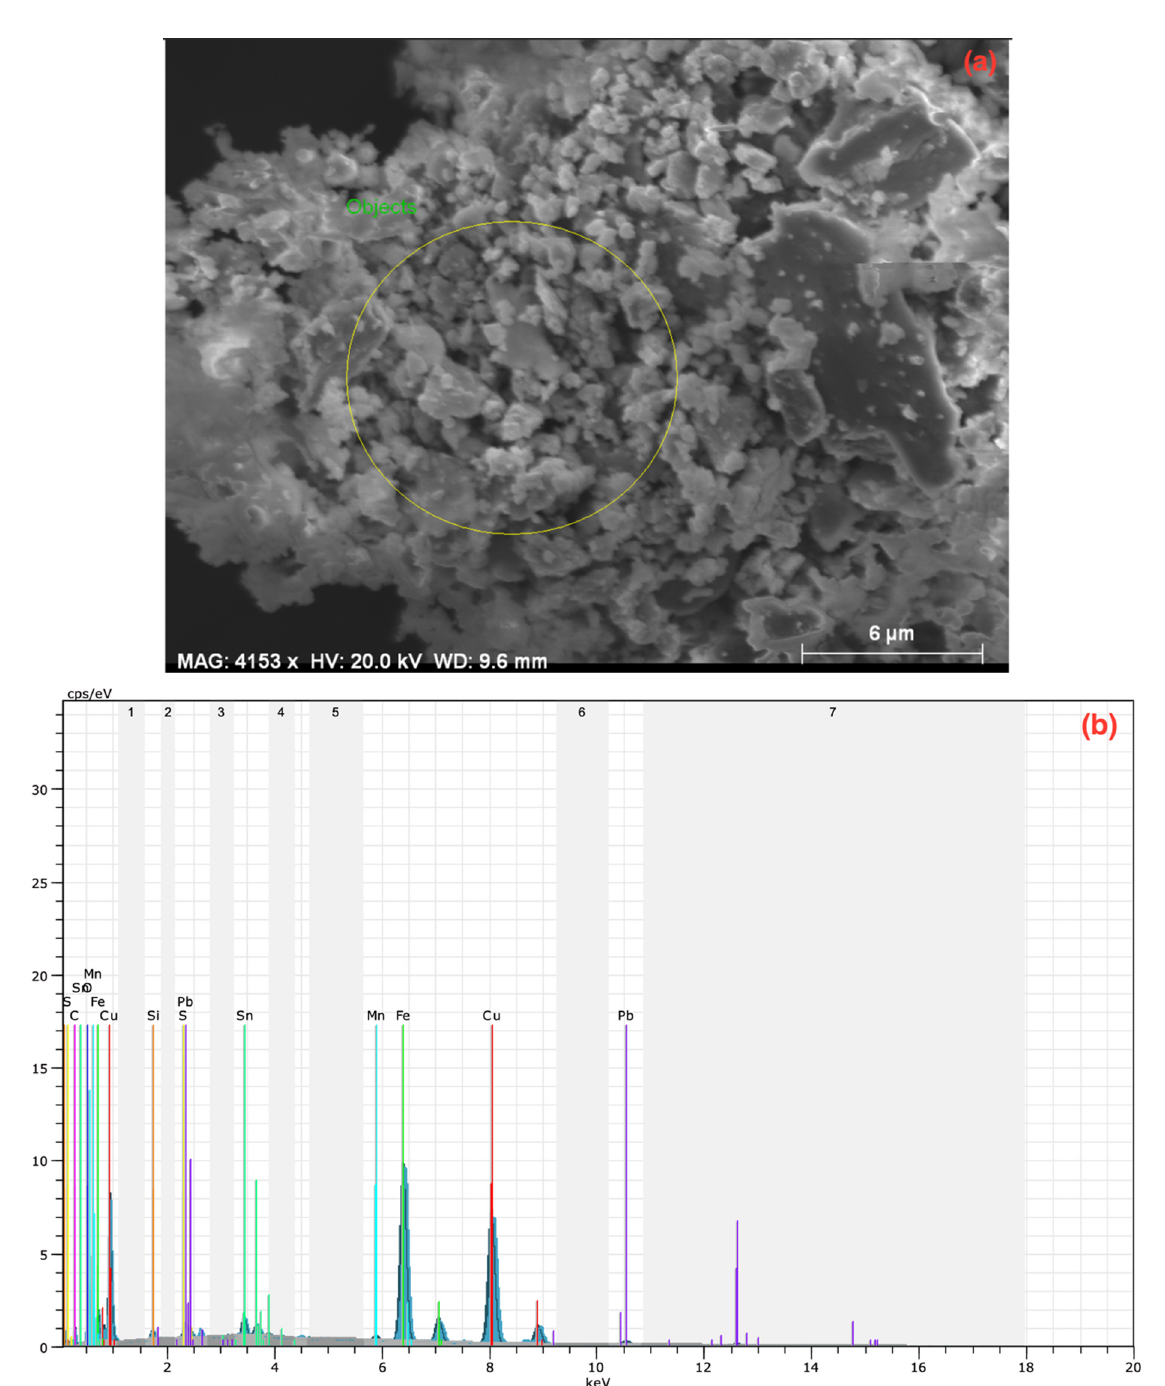
Figure 5. ( a ) SEM image and ( b ) EDS analysis of 60C40G particles after wear.